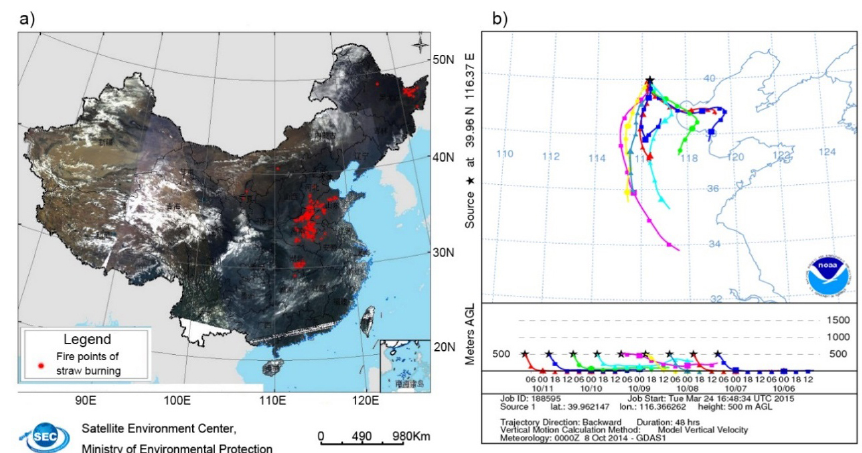
Figure 8. (a) Fire points of straw burning over China on 6 October 2014, (b) Backward trajectories from Beijing for Episode 1.